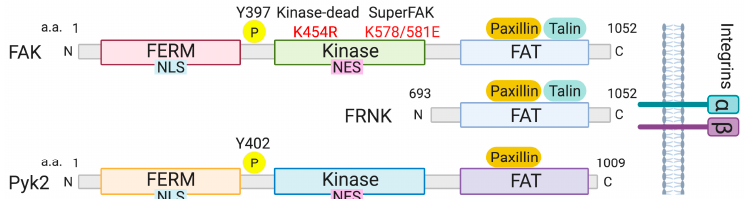
Figure 1. Structure of FAK, FRNK, and Pyk2. The main domains of FAK, FRNK and Pyk2 are shown. FAK and Pyk2 have three major domains: the N-terminal FERM (band 4.1-ezrin-radixin-moesin) domain, the central kinase domain, and the C-terminal focal adhesion-targeting (FAT) domain. FAK and Pyk2 localize to integrin-containing adhesions via their FAT domains. Upon kinase activation, autophosphorylation at tyrosine (Y) 397 FAK and Y402 Pyk2 provides a binding site for Src-homology